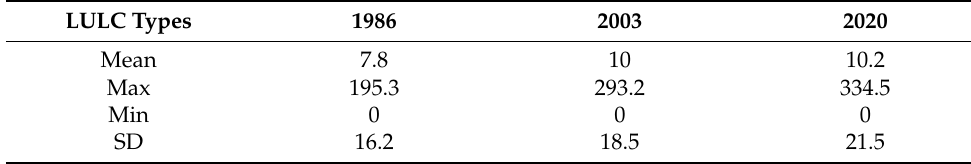
Table 9. Soil sediment (ton/ha/year) result during 1986, 2003, and 2020.